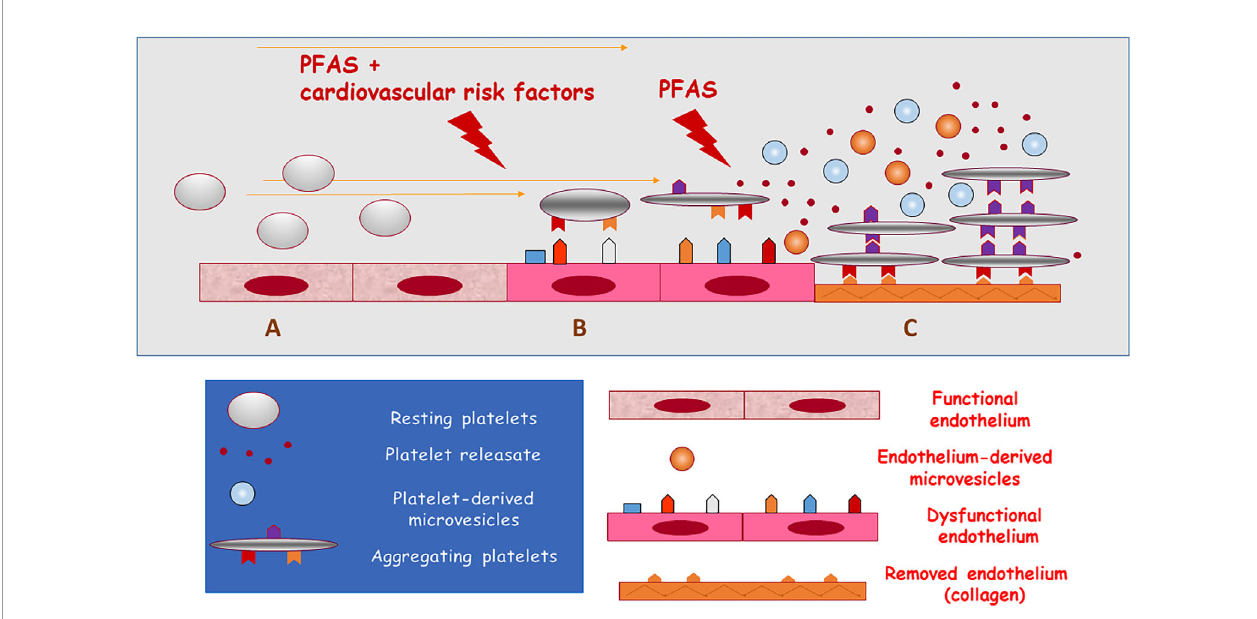
FIGURE 1 | Updated hypothesis on the association of exposure to PFAS with cardiovascular disease and death. PFAS may promote arterial thrombosis by increasing cardiovascular risk (causing lipid and glucose disorders and arterial hypertension) or by directly activating platelets. (A) functional endothelial and resting circulating platelets; (B) exposure to PFAS and cardiovascular risk factors induce endothelial dysfunction and the activation of circulating platelets (release of microvesicles); (C) exposure to PFAS directly induces platelet adhesion and aggregation when endothelium has been removed or damaged and collagen is exposed to blood fl ow (release of prothrombotic substances and microvesicles from aggregating platelets) thus causing arterial